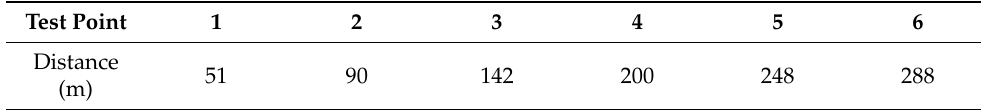
Table 1. Distance of The Six Test Points From The Test Cell.